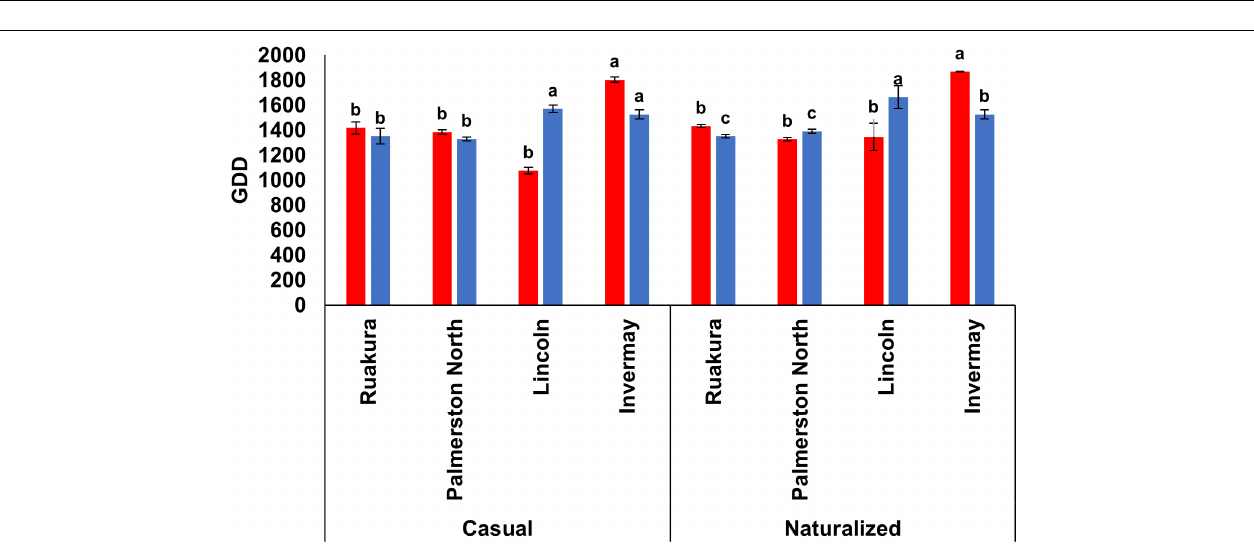
FIGURE 7 | Accumulated growing degree days (GDD) required by the casual and naturalized populations of A. theophrasti in five different regions of New Zealand to develop first seed capsules in the first (red bars) and second (blue bars) experiments. No seed capsules were developed by plants in Woodlands in both experiments (in the second experiment, plants in Woodlands died after emergence). For each population, vertical bars of the same colour with different letters are significantly different at 5% probability. The error bars represent ± standard error of the mean.